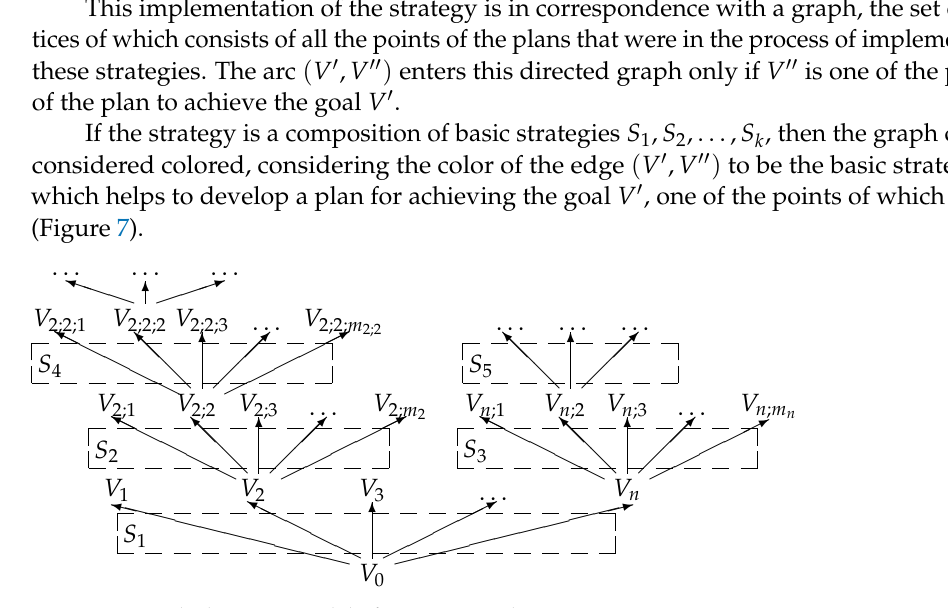
Figure 7. Graph-theoretic model of strategy